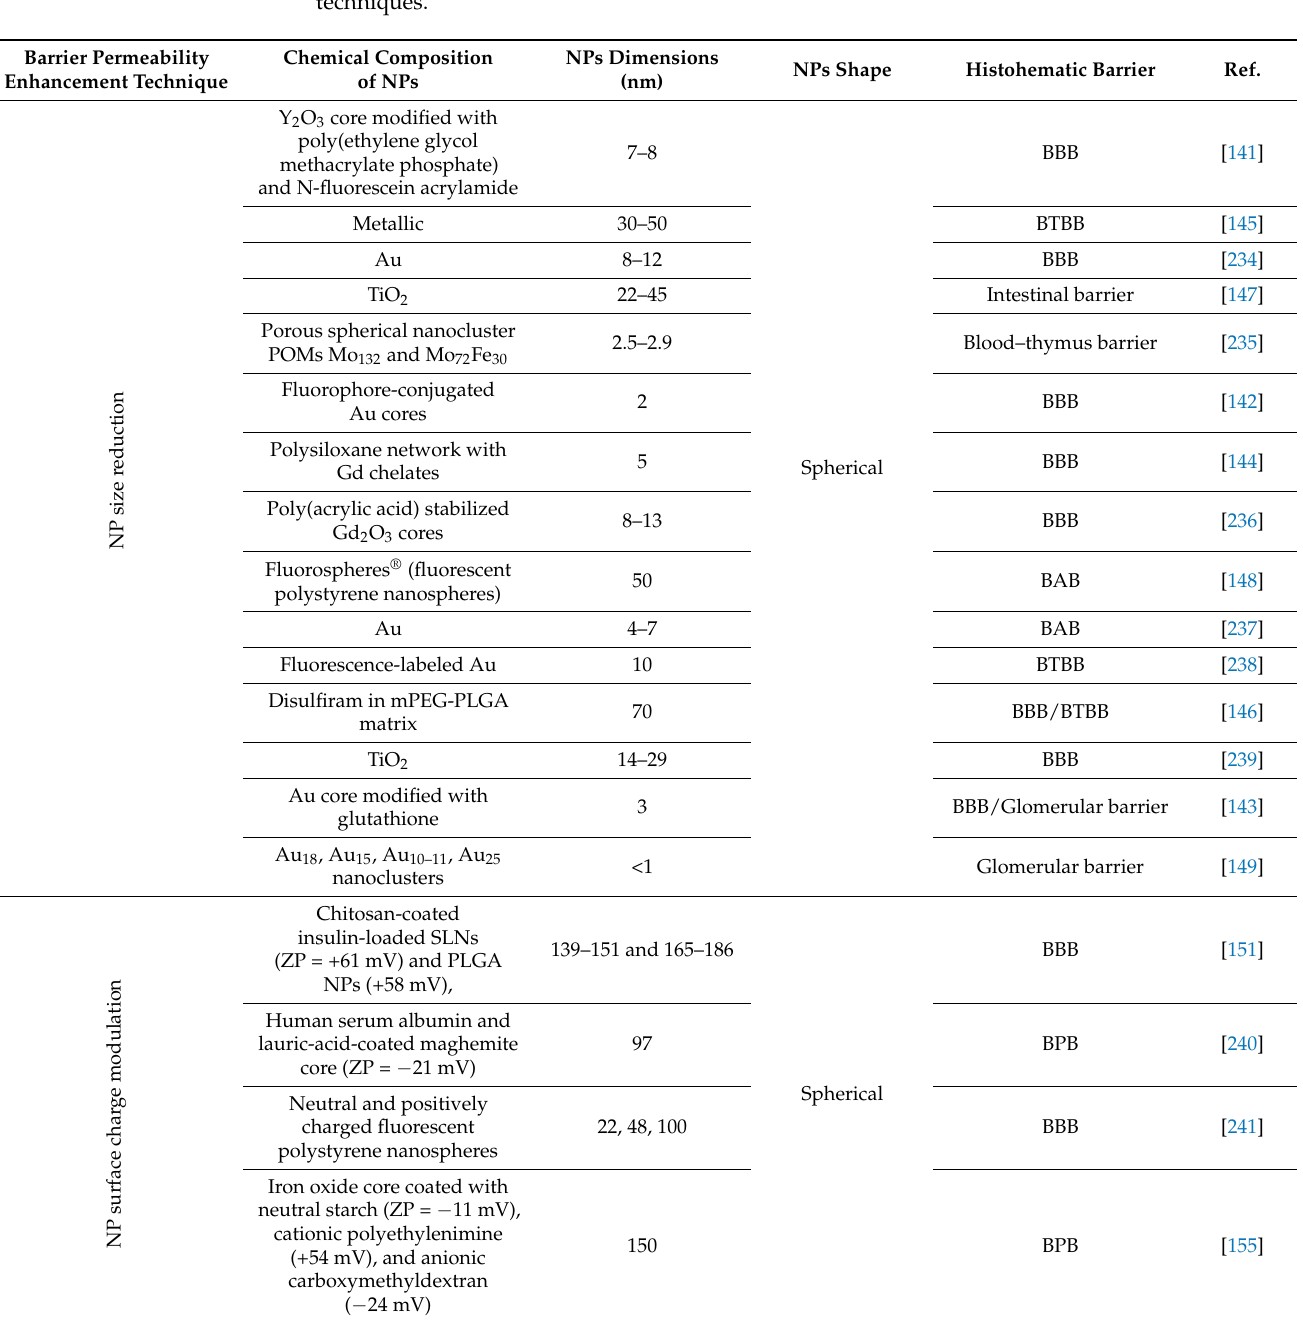
Table 4. The histohematic barriers permeability enhancement with the use of the various physical